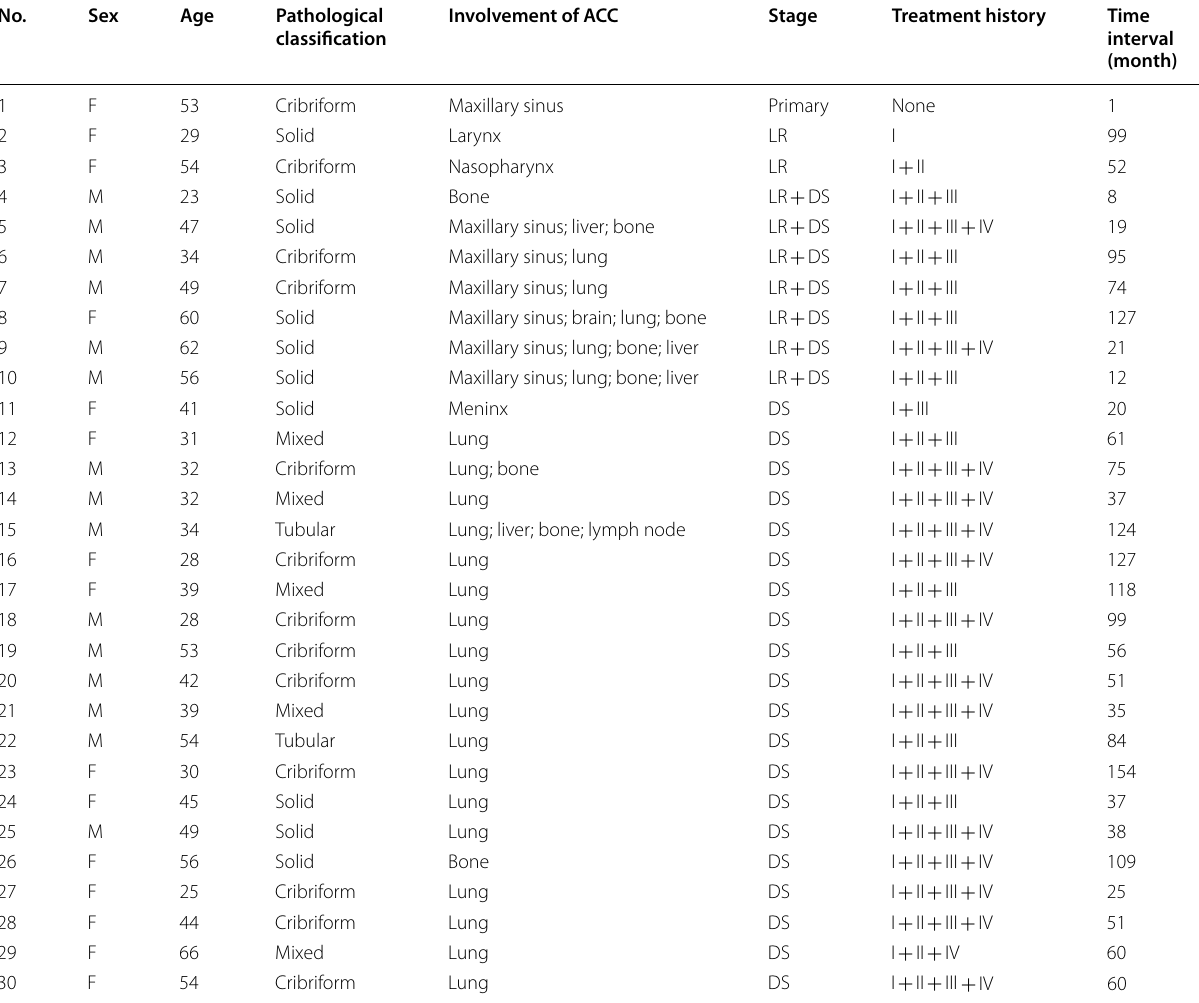
I surgery; II radiotherapy; III chemotherapy; IV targeted therapy ACC adenoid cystic carcinoma, Time interval time interval from diagnosis to PET/CT, LR local recurrence, DS distant metastases